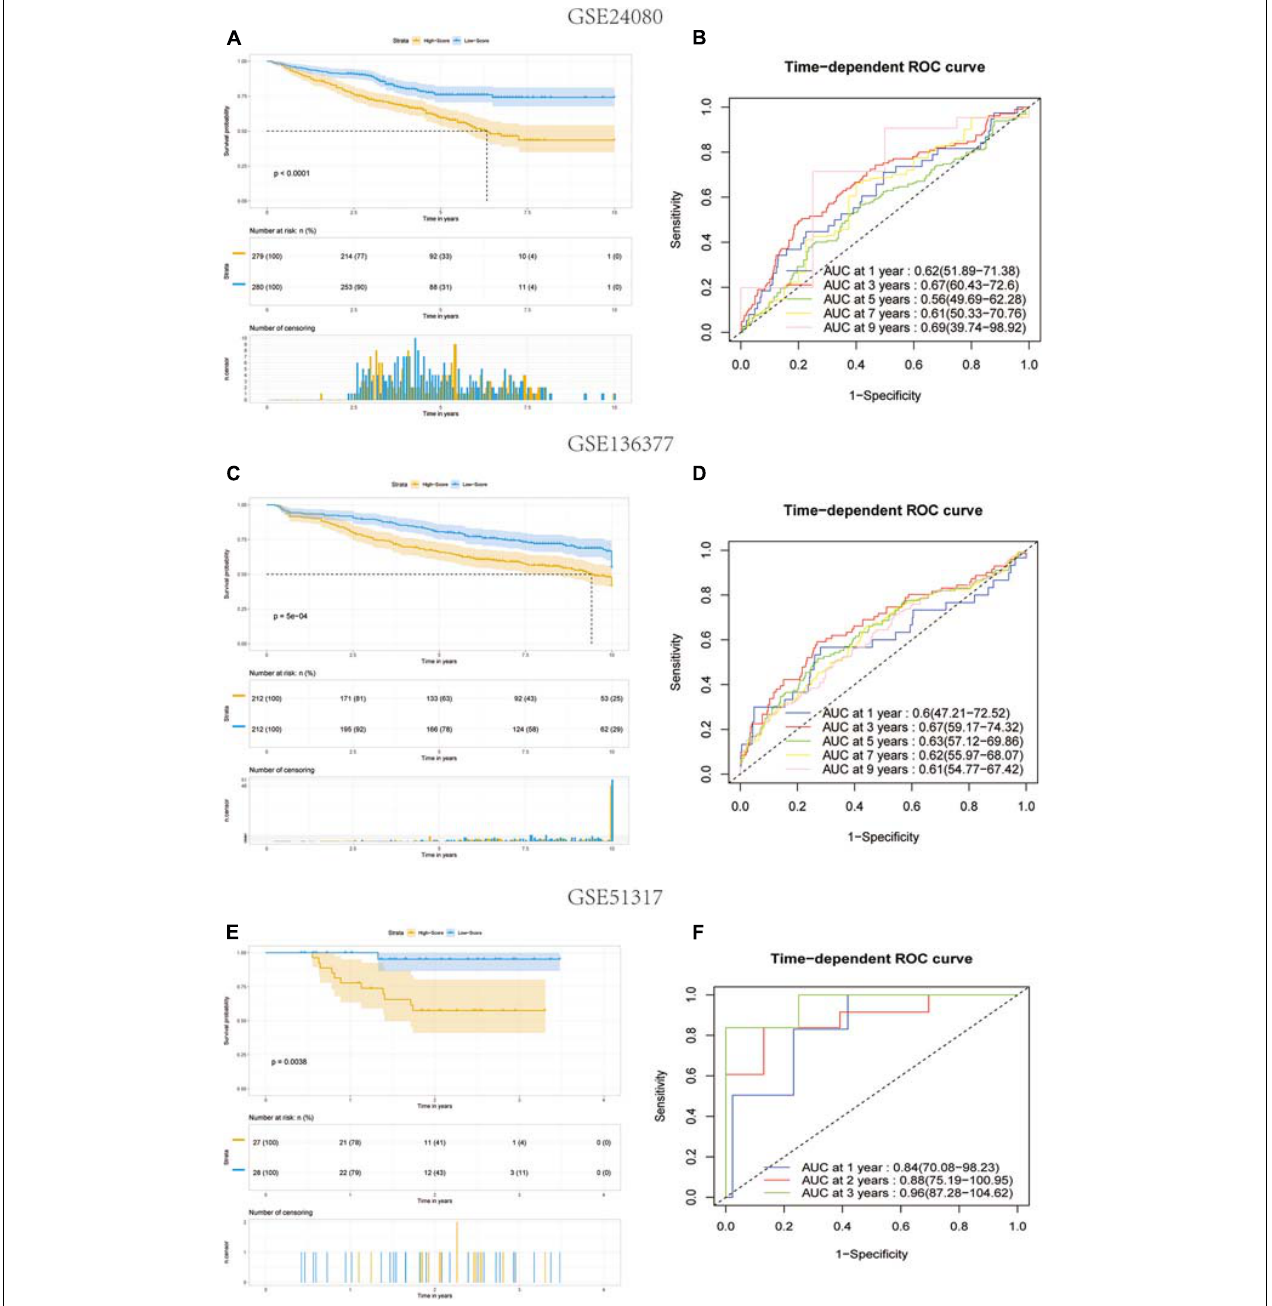
FIGURE 4 | Kaplan–Meier analysis and ROC analysis of 8-gene signature in three validation datasets. (A,B) Kaplan–Meier survival analysis of the low-score and high-score group patients and ROC curve analysis according to the 1-, 3-, 5-, 7-, and 9-year survival of the AUC value in the GSE24080 cohort. (C,D) Kaplan–Meier survival analysis of the low-score and high-score group patients and ROC curve analysis according to the 1-, 3-, 5-, 7-, and 9-year survival of the area under the AUC value in the GSE136337 cohort. (E,F) Kaplan–Meier survival analysis of the low-score and high-score group patients and ROC curve analysis according to the 1-, 2-, and 3-year survival of the AUC value in the GSE51317 cohort.